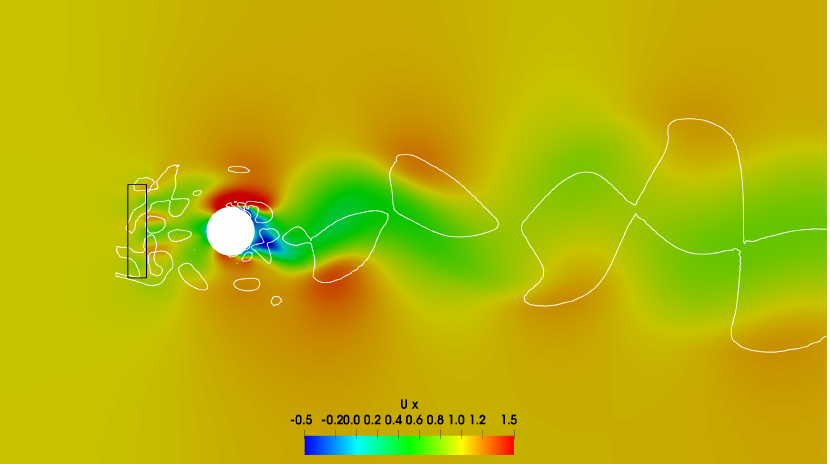
Figure 7. Cylinder flow with synthetic